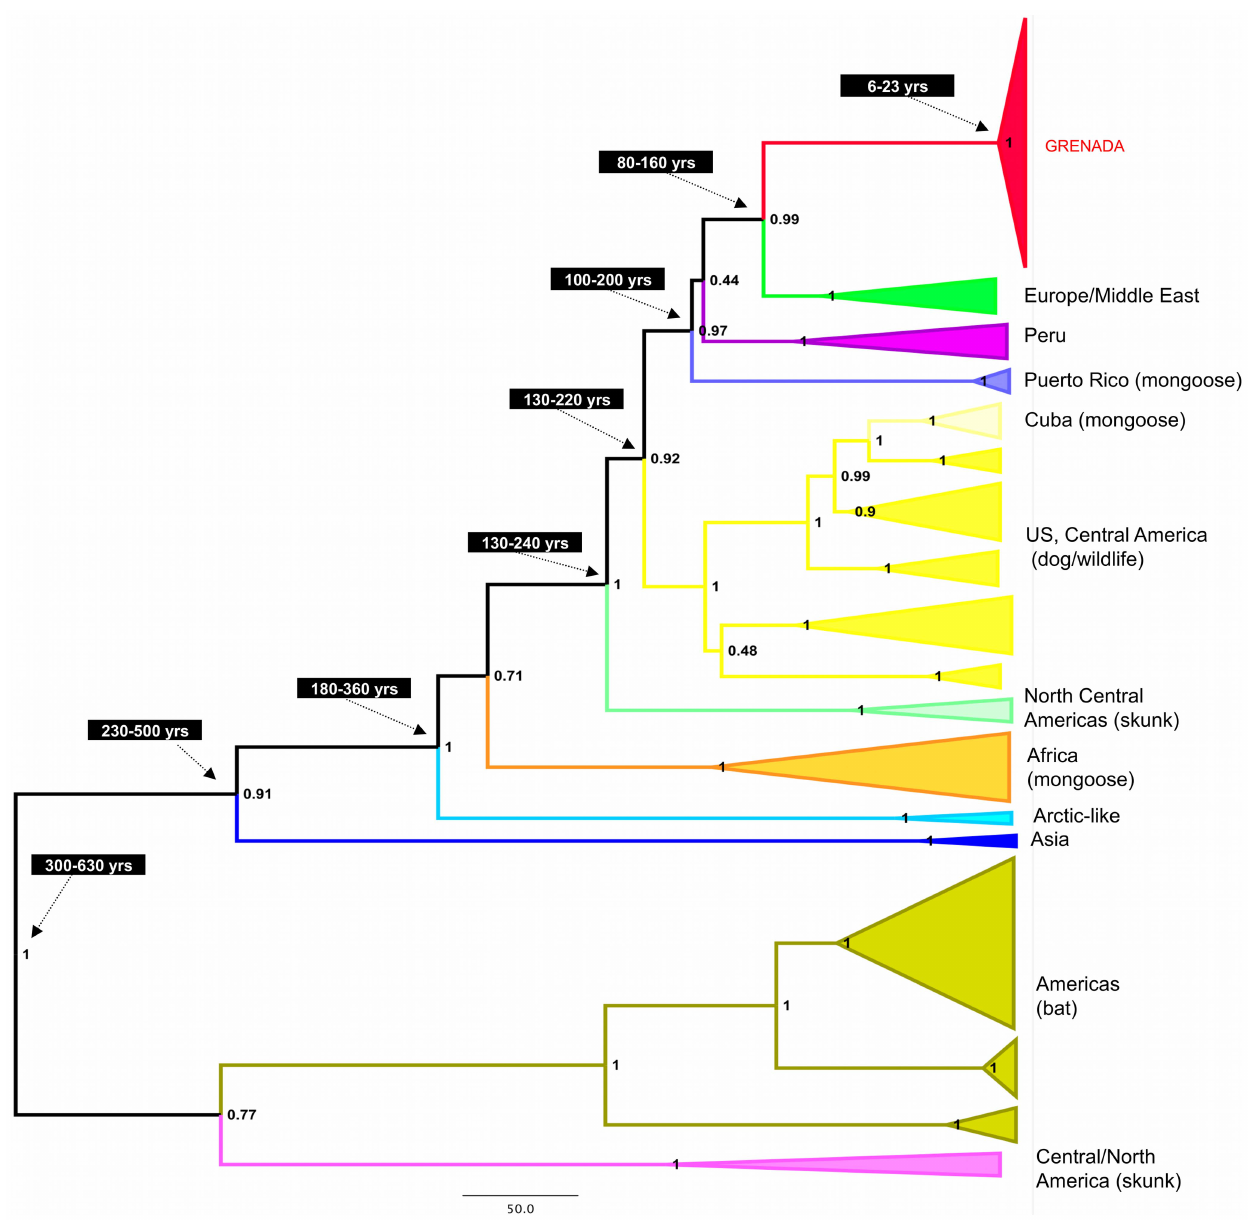
Figure 3. A maximum clade credibility tree, comparing 1350 bp N-gene sequence of rabies virus strains from Grenada (n=23) with representatives from a global panel of 80 rabies viruses (reference sequence identities in Figure S2). A relaxed (uncorrelated lognormal) molecular clock and Bayesian skyline population prior were used for 60 million iterations in the BEAST package (v1.8) The posterior probability is indicated at each node and estimates of the dates for ancestral nodes are indicated. Scale bar represents 50 years.